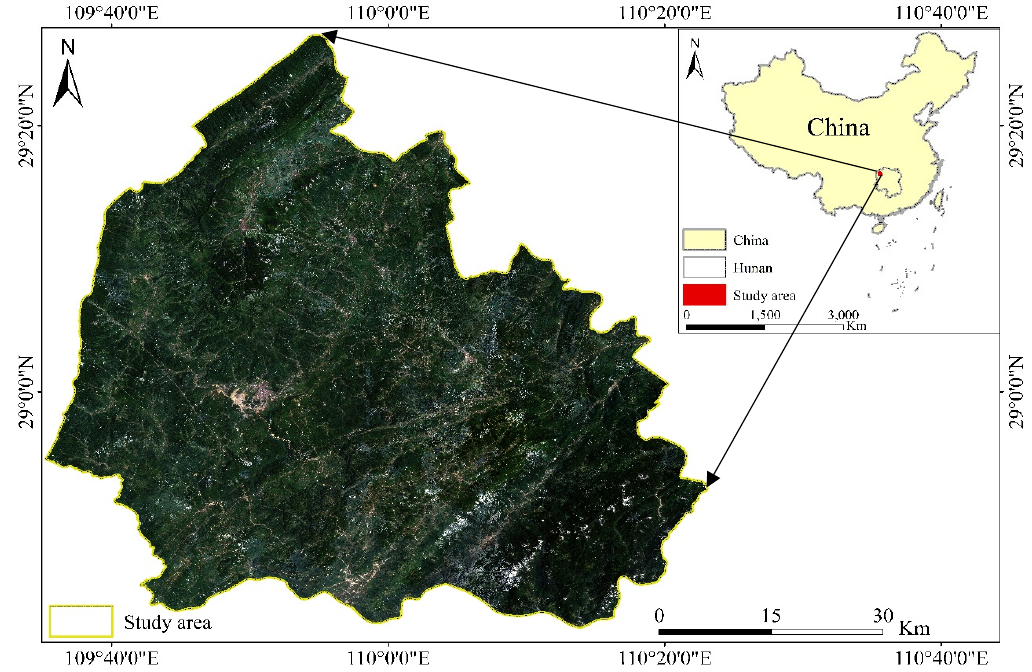
Figure 1. Location of study area in China. The image to the left is a true color composite (red, green, blue bands) from Sentinel-2. blue bands) from